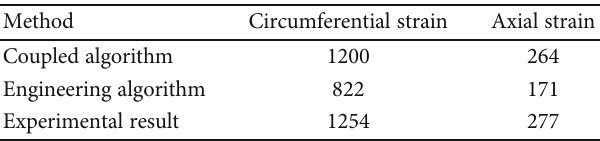
Figure 11: Temperature variations in exterior case of nozzle throat insert. Table 2: Comparisons of strain measurements with numerical